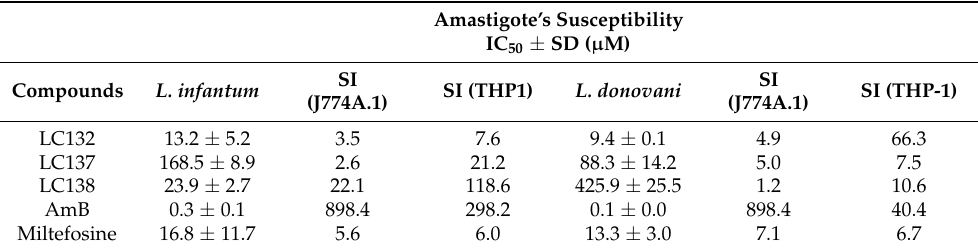
Table 2. IC 50 and SI of most active synthetic trioxolanes and control drugs, intracelular amastigote forms of L. infantum IMT151 and L. donovani BD14 after 48 h